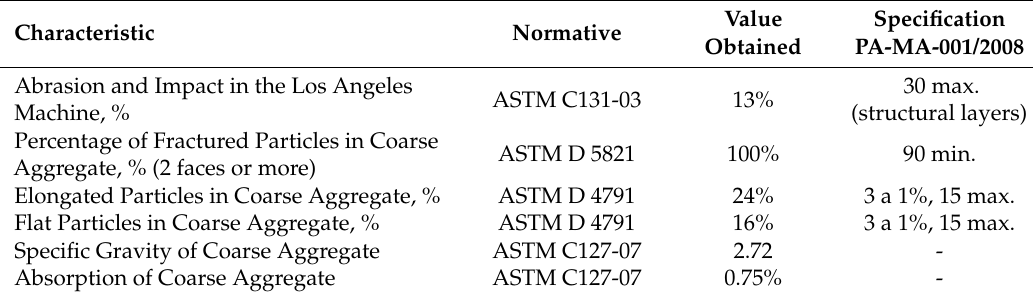
Table 1. Characteristics of the coarse aggregate.